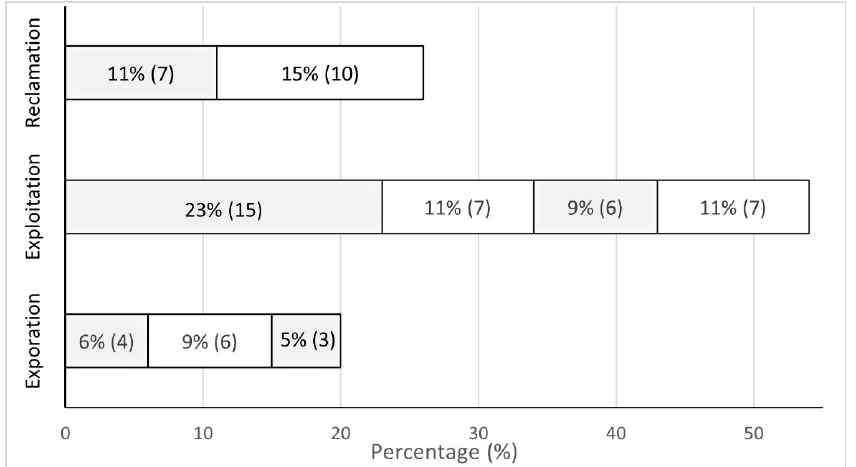
Figure 2. Percentage presentation of UAV application in each mining process phase [14].